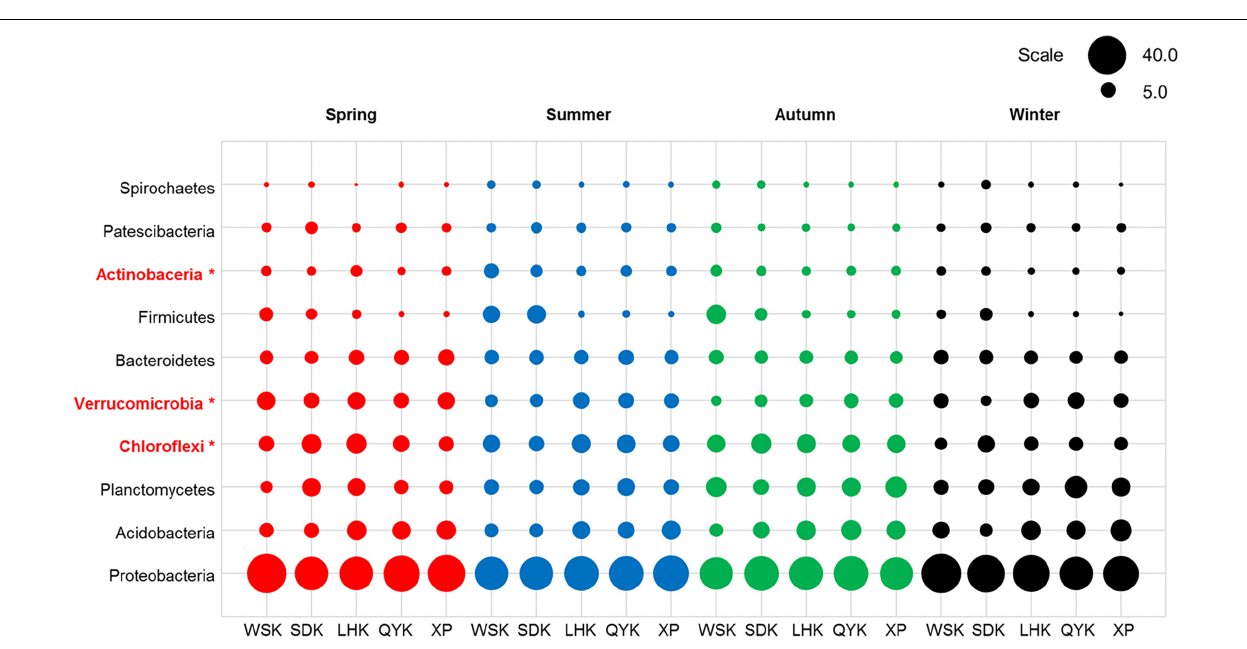
FIGURE 3 | Relative abundances of dominant bacterial phyla in sediments from different sampling sites among various seasons (Red = Spring, Blue = Summer, Green = Autumn, Black = Winter). Asterisks represent a significant difference among the seasons according to Kruskal-Wallis H-test from STAMP pipeline (Kruskal-Wallis H-test, P <